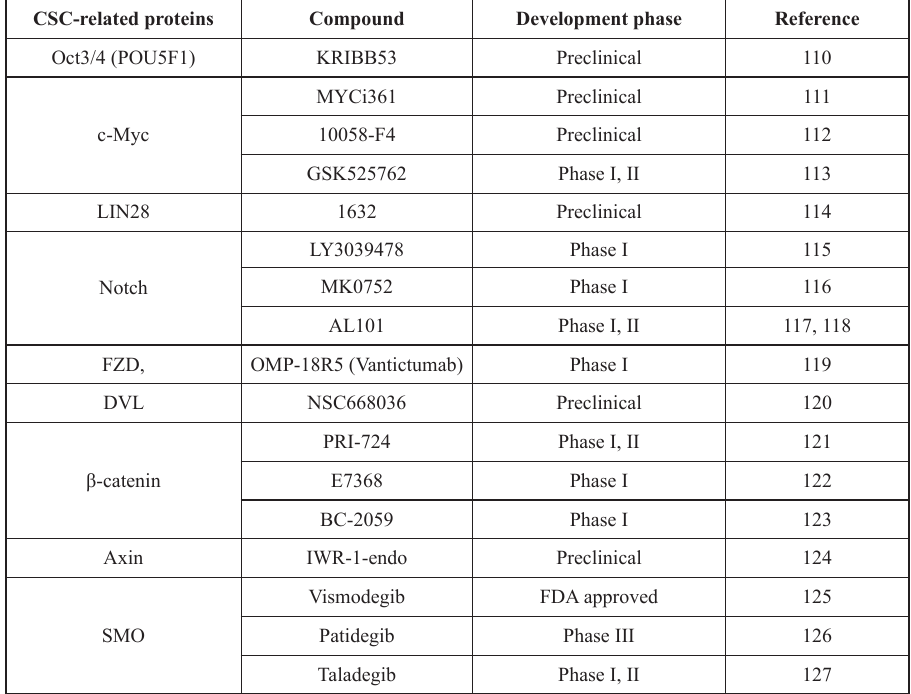
Table 2: The summary of drugs targeting the CSC-related